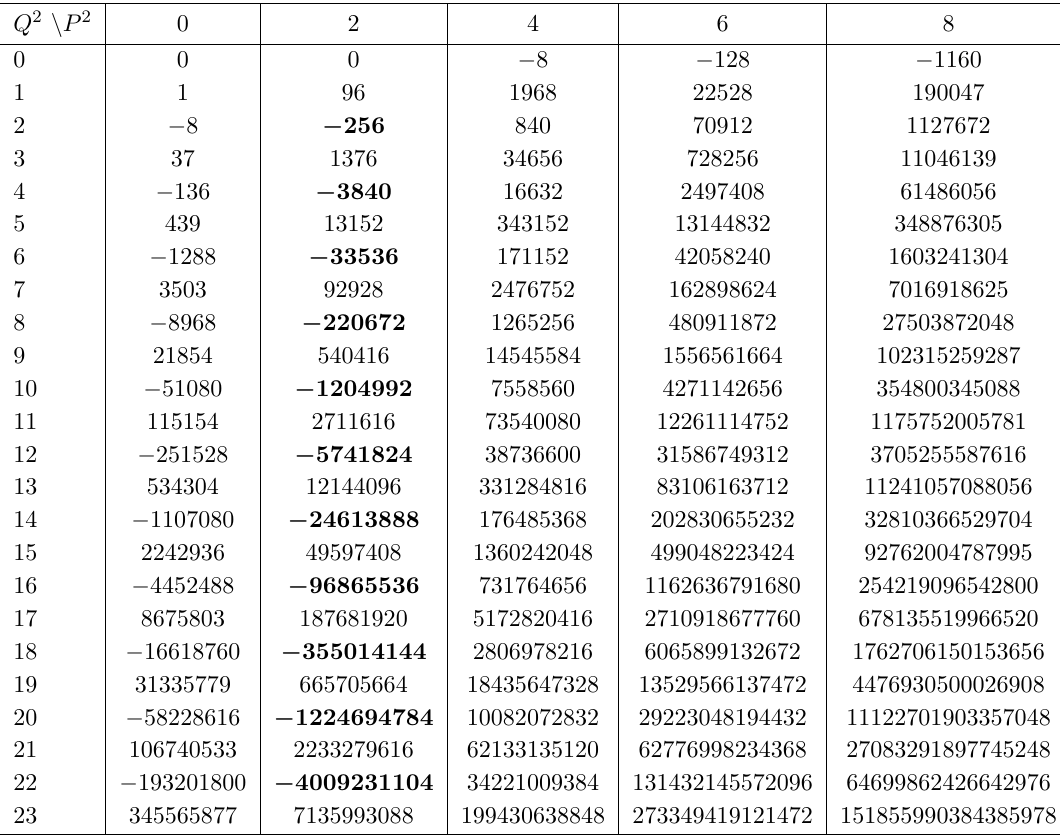
Table 18 . The index d ( Q; P ) for the Z 2 toroidal orbifold some low lying values of Q 2 , P 2 with Q (cid:1) P =